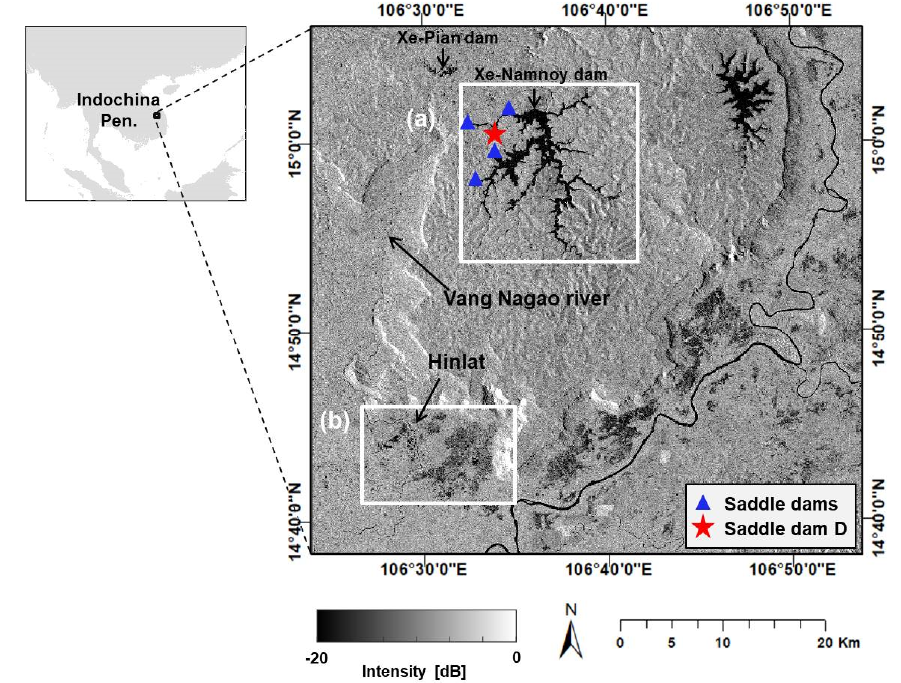
Figure 1. Map of the study area showing the locations of the study sites. ( a ) Xe-Namnoy reservoir, ( b ) Hinlat area. The four saddle dams are indicated with blue triangle. Saddle Dam D, which collapsed on 23 July 2018, is marked with a red star. Remote Sens. 2020 , 12 , x FOR PEER REVIEW